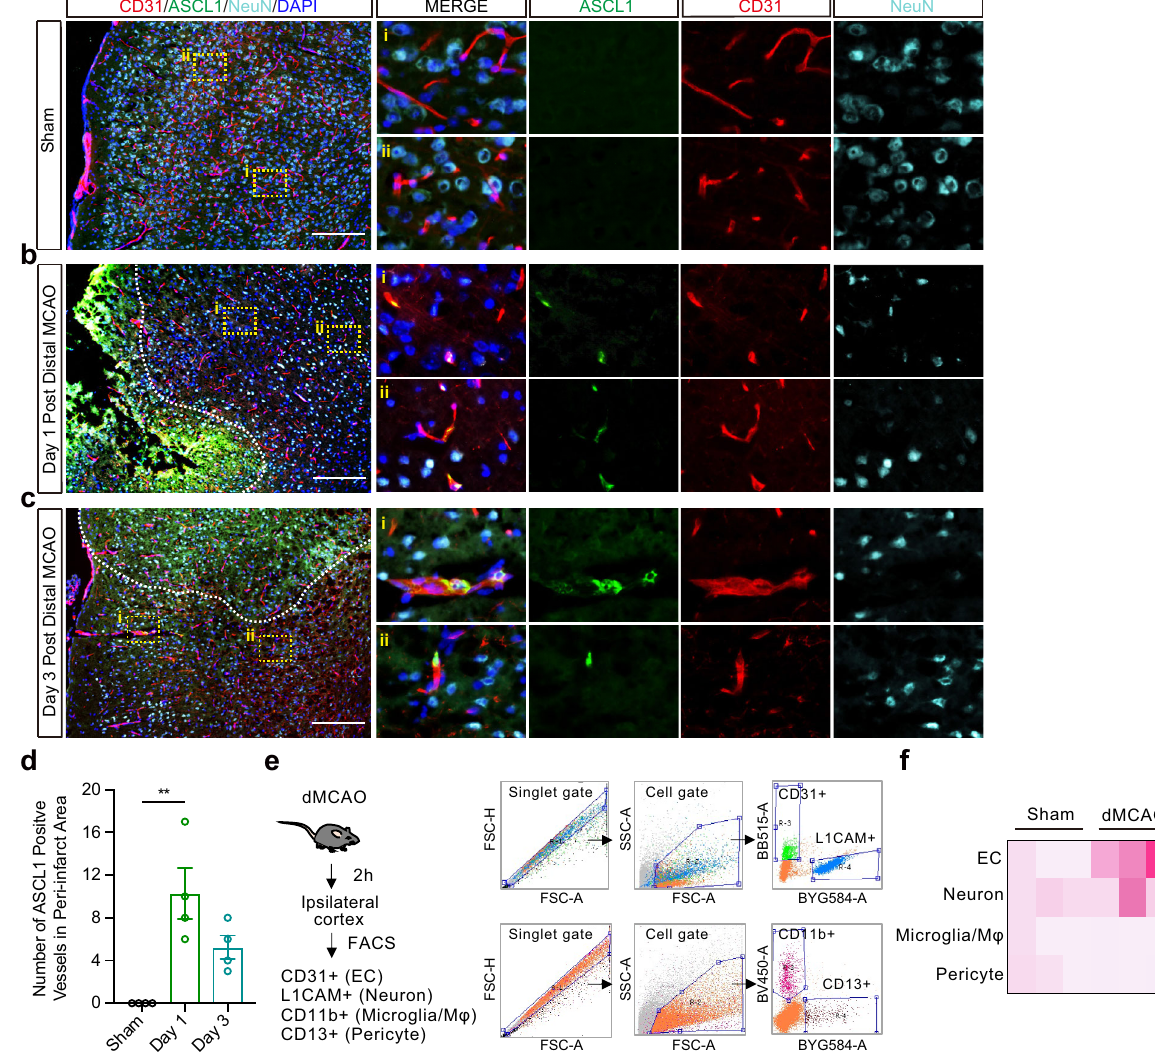
Fig. 4 | Pro-neural transcription factorAscl1is expressed in brain microvessels after focal cerebral ischemia in mice. Representative immunostaining of Ascl1, CD31,andNeuN atshame( a ), day1( b ),and day3( c )postpermanentdistalmiddle cerebral artery occlusion (MCAO); Dashed white line indicates lesion border. d Vessels were counted in 0.5 mm 2 peri-infarct ROIs per section (totally 3 sections per mouse, 4 miceper group;Criteria isany loci with morethan one Ascl1positive